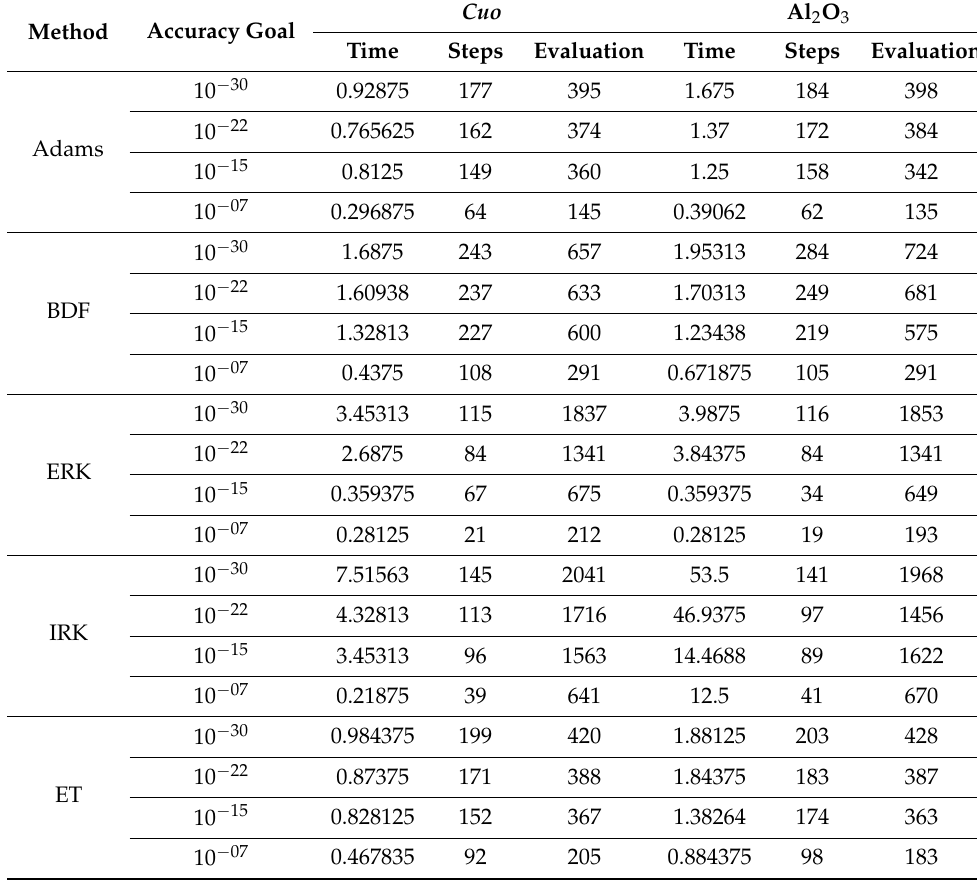
Table 5. Convergence and complexity test for k 0 =